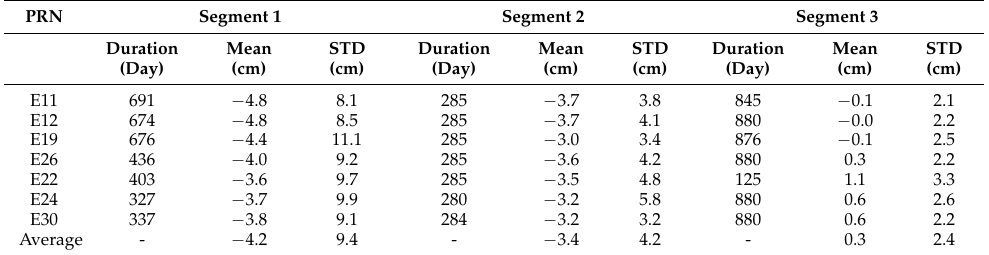
Table 7. Statistical information for COM-GBM orbit differences in the radial